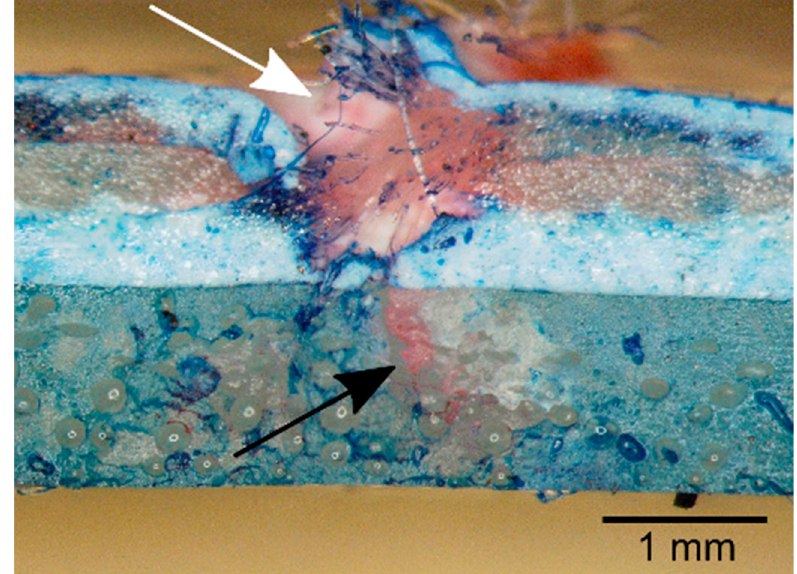
Figure 8. Cross-section of a test sample consisting of the fiber-reinforced membrane (top) and the foam coating (bottom). To improve the visibility of the structures, the surface was treated with a blue stamping ink. Before being used to puncture the membrane, the nail was dipped in red ink in order to make the puncture channel clearly visible. The membrane shows clear damage by the puncturing of the nail (white arrow), whereas the surfaces of the puncture channel in the foam (black arrow) lie on each other so precisely that the channel is recognizable only by the red color.